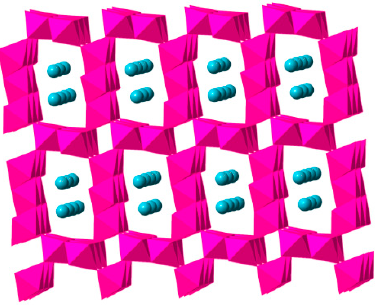
Figure 6. Schematic illustration of the crystal structure of Na 2 Mn 5 O 10 . This structure consists of purple octahedral units MnO 6 shared by corners and/or edges, where Na + occupies positions within channels formed by octahedrals units (JCPDS 27-0749).